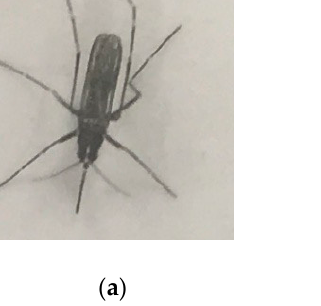
Figure 2. Clipped mosquitoes from the images captured using a single-lens reflex camera: ( a ) Aedes albopictus , ( b ) Anopheles stephensi , and ( c ) Culex pipiens pallens .